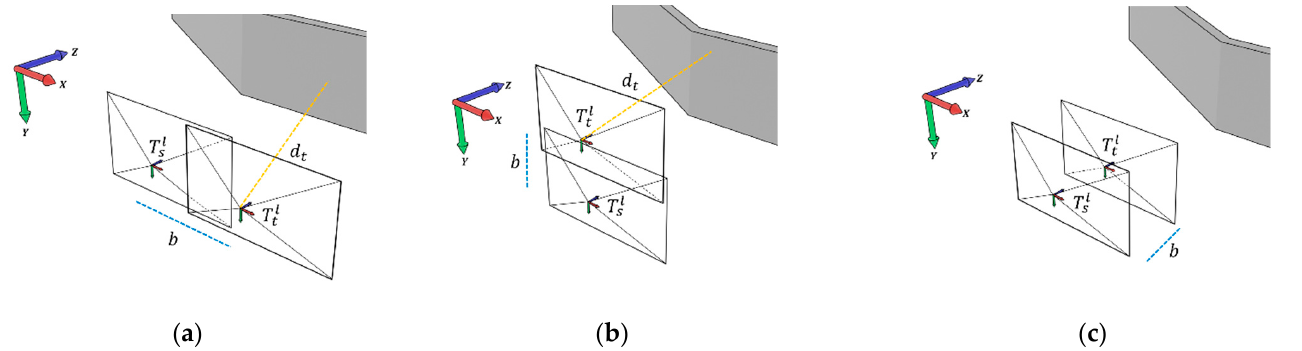
Figure 4. Visualization, relative to the left camera of the stereo system, of the different cases considered by the acquisition control: movement along the camera ( a ) X axis and ( b ) Y axis. ( c ) The movement along the Z axis, less common in photogrammetric acquisitions, is handled with a preset constant baseline k .